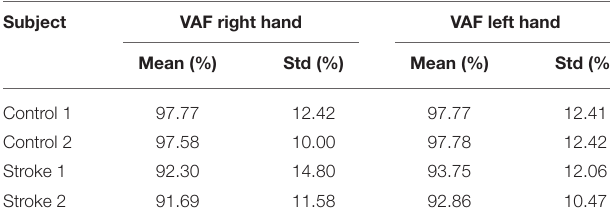
Frontiers in Neural Circuits |